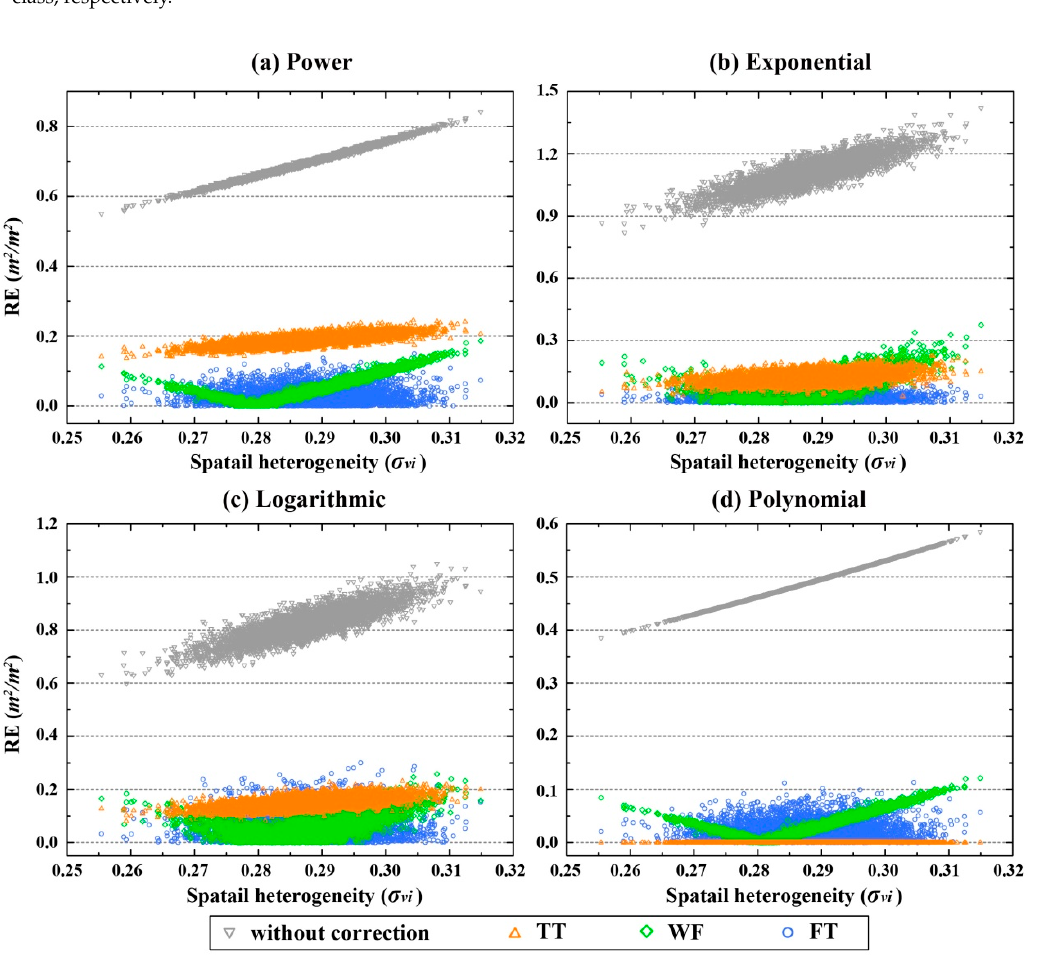
Figure 9. Correction of the scaling bias mainly caused by spatial heterogeneity ( σ vi ) using the three techniques (TT, WF, and FT) for LAI estimation models of ( a ) power function, ( b ) exponential function, ( c ) logarithmic function, and ( d ) polynomial function.